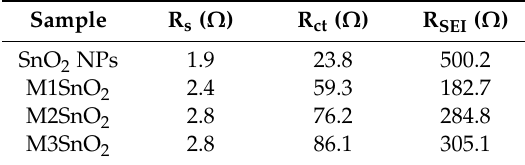
Table 1. Resistance values extracted from the equivalent circuit of M1/M2/M3SnO 2 anodes.